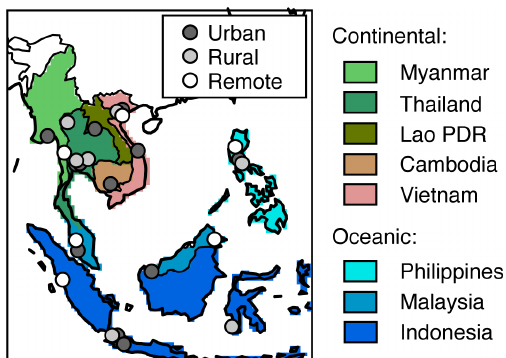
Figure 1. Map of southeast Asia. Circles with different colors indi- cate observation sites classified as remote (white), rural (light gray), and urban (dark gray) by the Acid Deposition Monitoring Network in East Asia (EANET). Map colors indicate the eight countries par- ticipating in EANET in